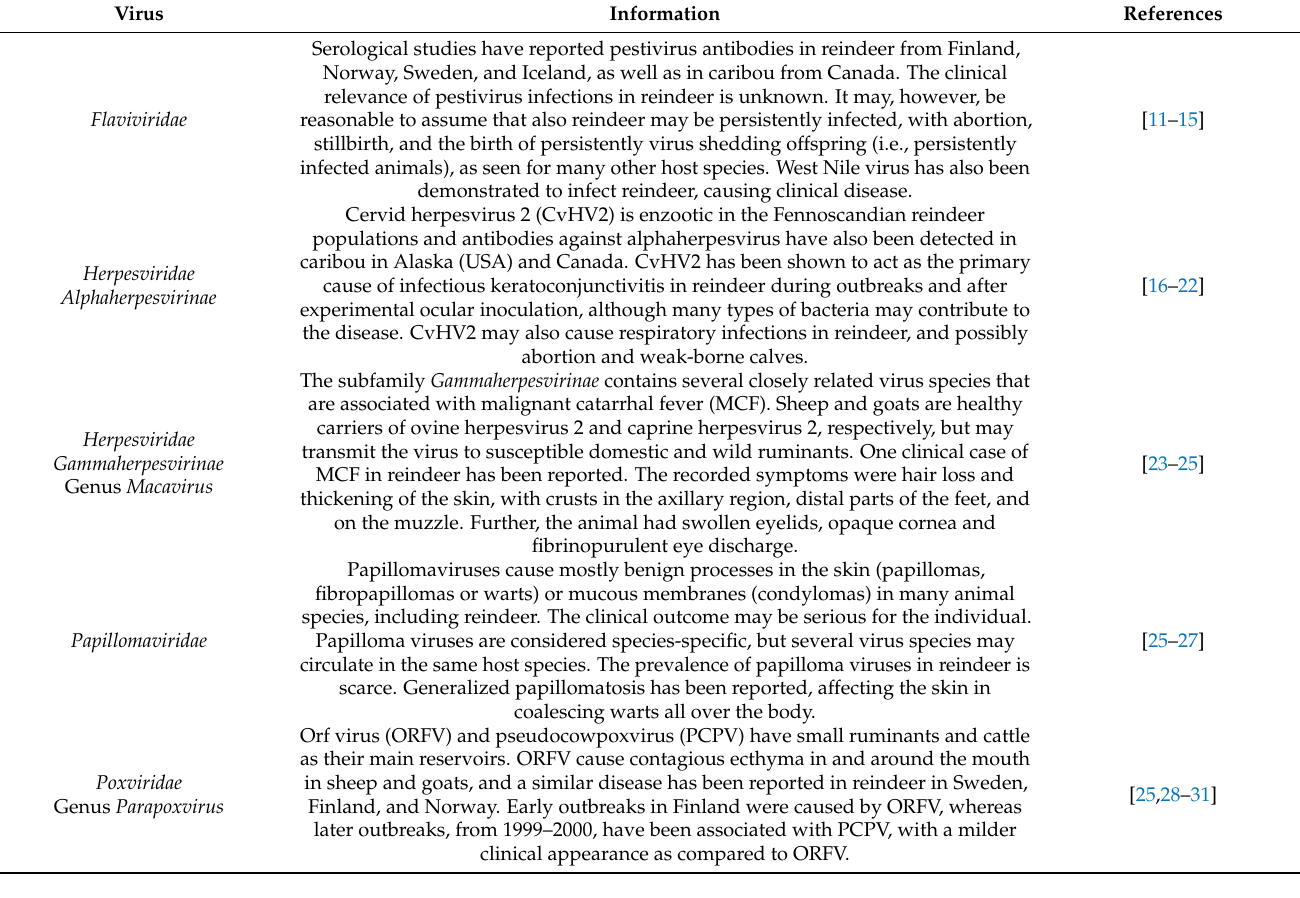
Table 1. Virus infections of known or potential clinical relevance identified to circulate in Eurasian tundra reindeer ( Rangifer tarandus tarandus